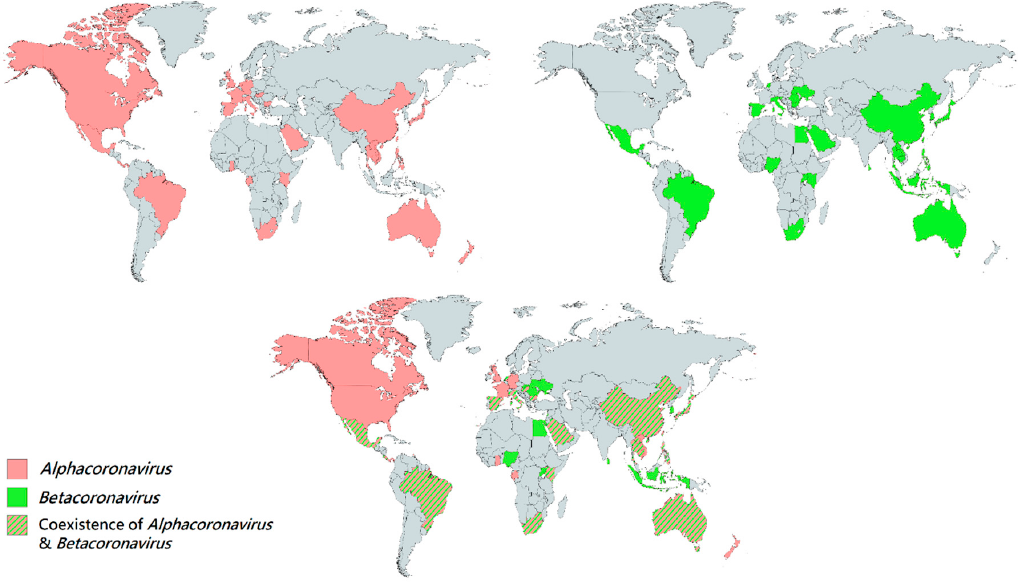
Figure 2. Geographical distribution of bat CoVs from the genera Alphacoronavirus and Betacoronavirus . Each colored region represents the country which reported the discovery of bat CoV. Red regions represent the countries which discovered bat Alphacoornavirus . Green regions represent the countries which discovered bat Betacoronavirus . Red-green striped regions represent the countries which discovered both bat Alphacoronavirus and Betacoronavirus .